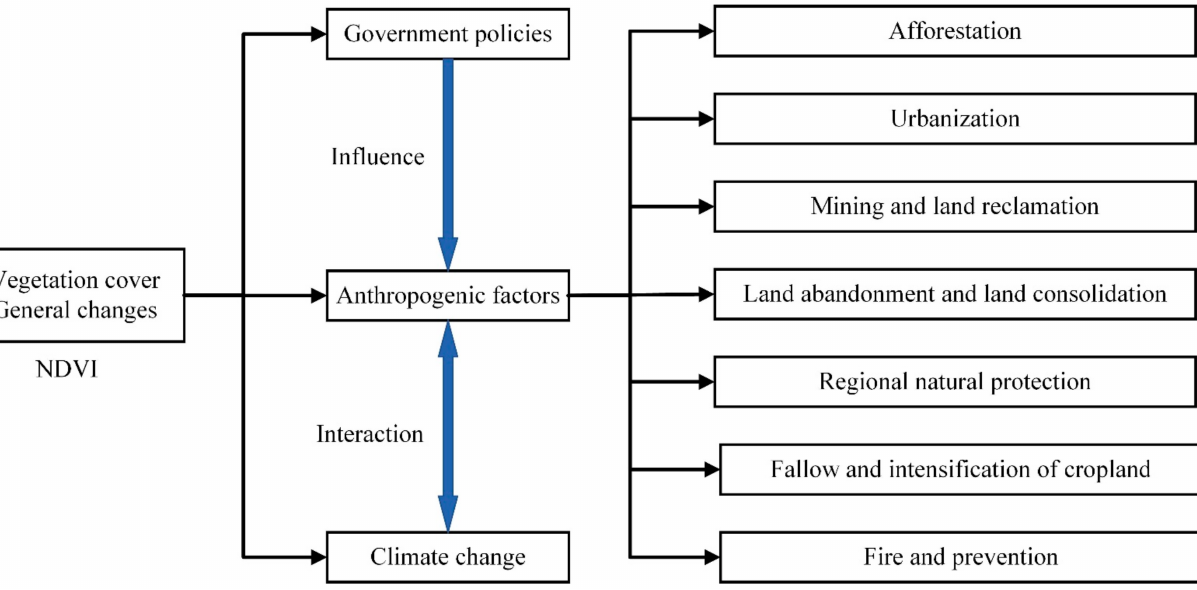
Figure 1. Workflow of the